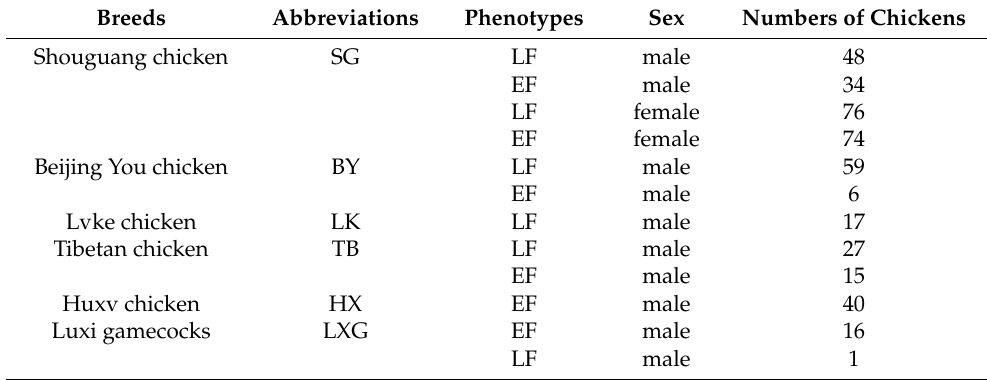
Table 1. List of chicken breeds used in this study.